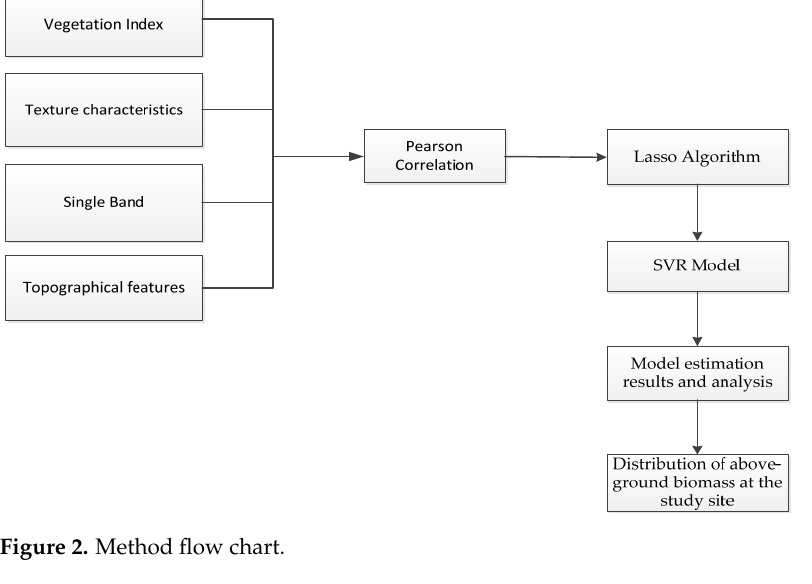
Figure 2. Method flow chart.